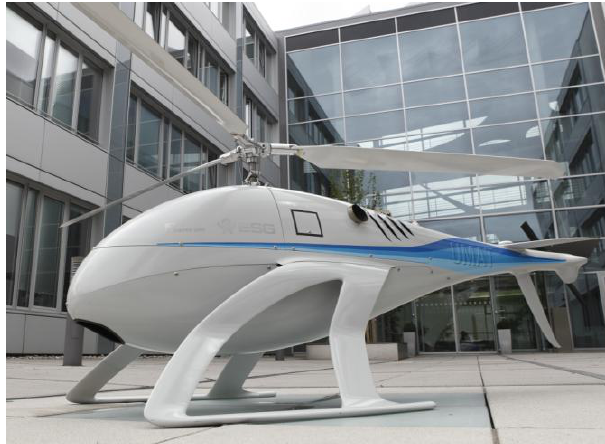
Fig. 2 Current Ground Control Station of the Swiss UAV NEO S-350 Twin